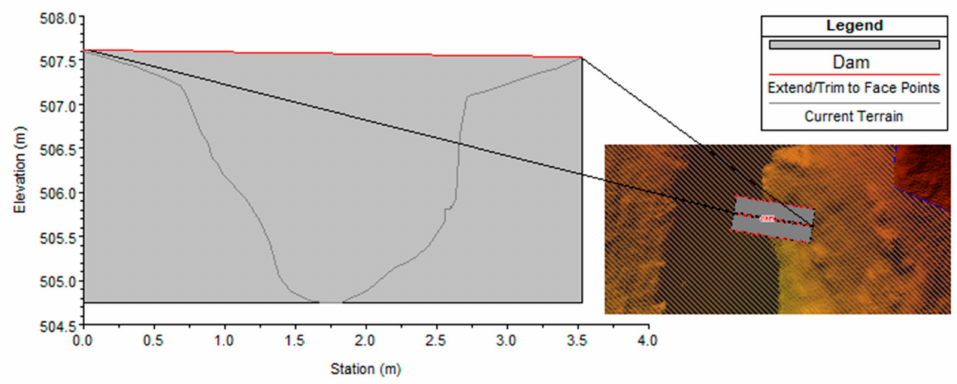
Figure 10. Dam technical characteristics simulation